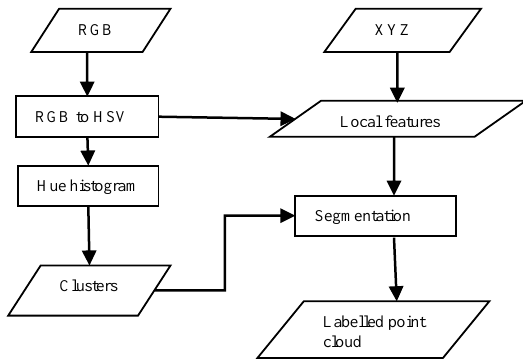
Figure 6. Overview of the radiometric segmentation approach